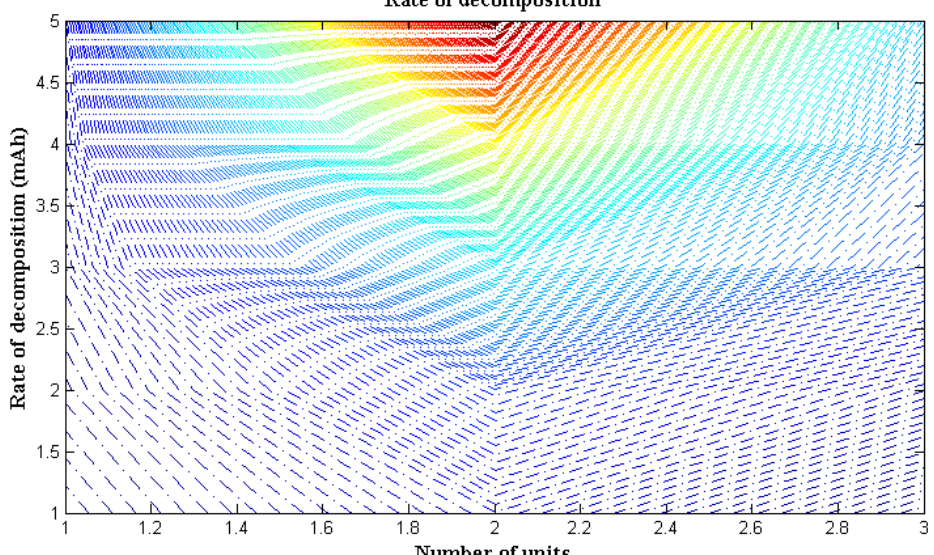
Figure 4. Rate of decomposition. The color changes in this figure represents various changes in decomposition rate that varies with number of units. For smaller number of units blue color is represented whereas for increasing units green and red color representations are